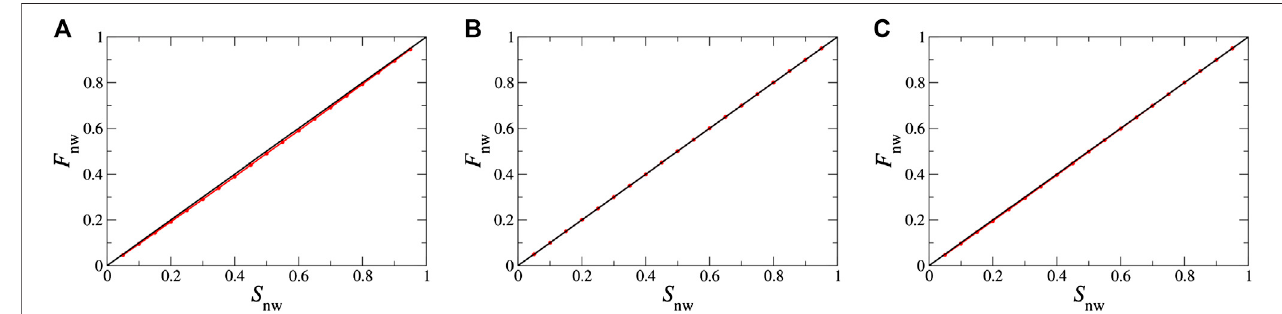
FIGURE 5 | Plot of steady-state non-wetting fractional fl ow F n as a function of non-wetting saturation S n for zero capillary pressure at the menisci. The three plots correspond to the three merging schemes (A) merge_back, (B) merge_cm and (C) merge_cmnn as described in Section 3.3. A small but systematic deviation from the diagonal F n (cid:1) S n line can be observed for A